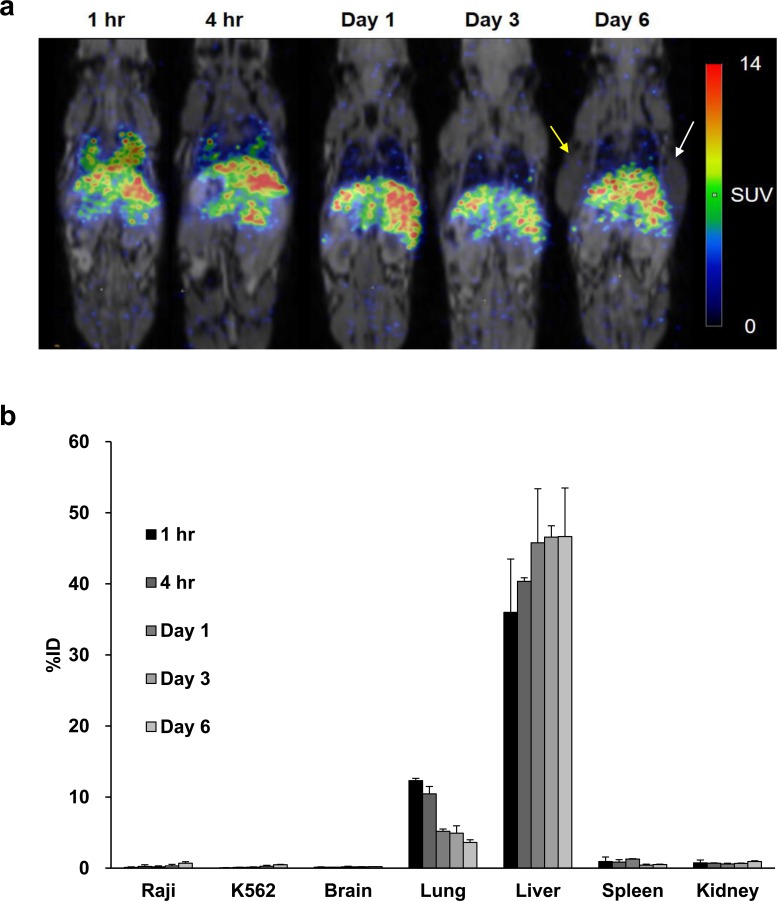
Serial 89Zr-DFO-labeled hPBMC CAR T-cells animal PET/MR images and analysis of biodistribution.a PET images of whole-body distribution for intravenously injected 89Zr-DFO-labeled hPBMC CAR T-cells in NSG mouse xenograft over the following six days. Yellow arrow and white arrow represent Raji tumor and K562 tumor, respectively. b The distribution in in vivo organs measured by 89Zr-DFO PET imaging over the following six days (n = 2).